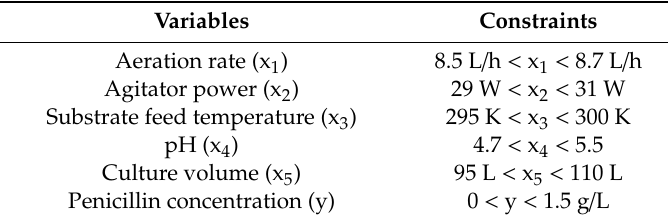
Table 6. Constraints of the critical variables.